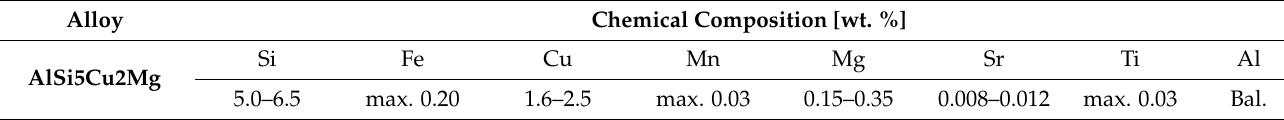
Table 3. Required chemical composition of the AlSi5Cu2Mg